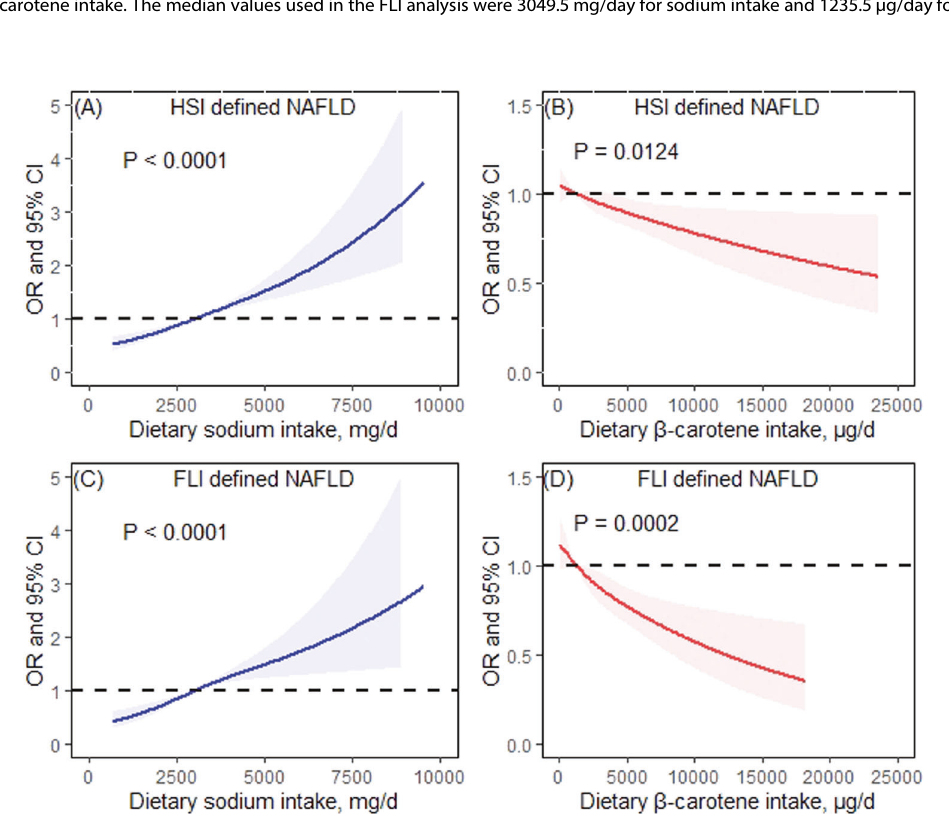
Fig. 3 Dose – response associations of dietary sodium and β -carotene intakes with no-alcoholic fatty liver disease (NAFLD). The restricted cubic spline model was basically adjusted for age, sex, ethnicity, education level, family monthly poverty level, smoking, drinking, sedentary time, total energy intake, dietary in fl ammatory index, and serum creatinine. A and C additionally adjusted for dietary β -carotene intake; B and D additionally adjusted for dietary sodium